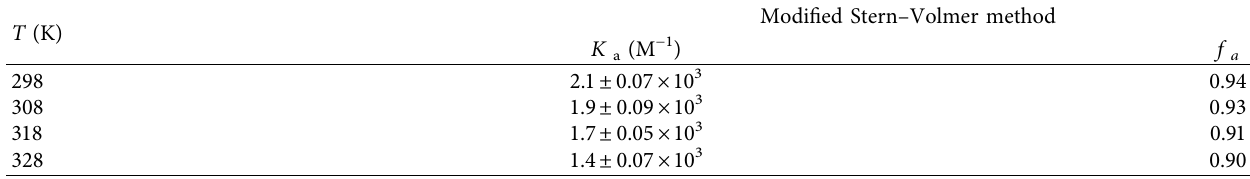
Table 2: Values of K a and K LB of the BSA–cuminaldehyde interaction at various